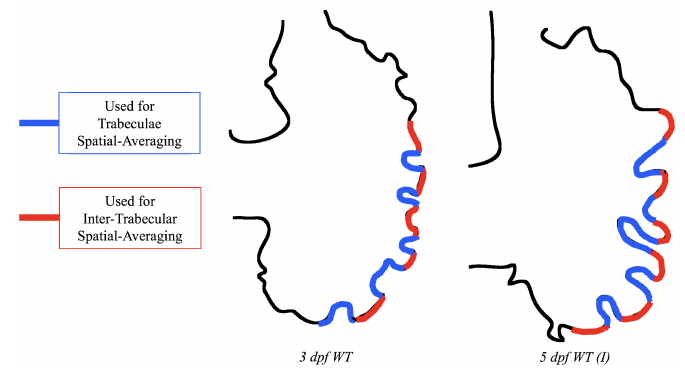
Figure A5. Plots detailing what regions were considered for spatially-averaging the WSS on the trabeculae and intertrabecular regions.